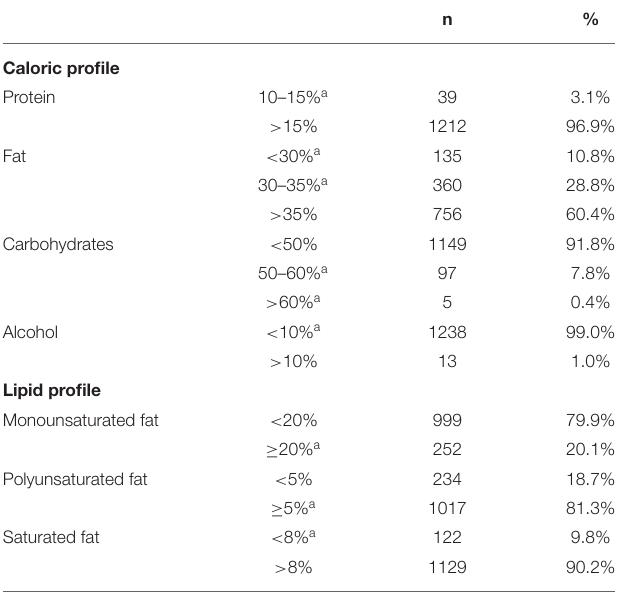
TABLE 1 | Caloric profile and lipid profile a